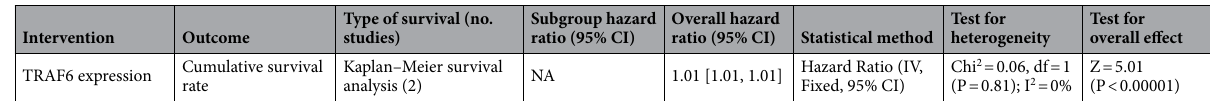
Type of survival (no. Intervention Outcome studies) TRAF6 Table 4. Summary of meta-analysis of included studies showing significant association of TRAF6 modulation and breast cancer survival rate.